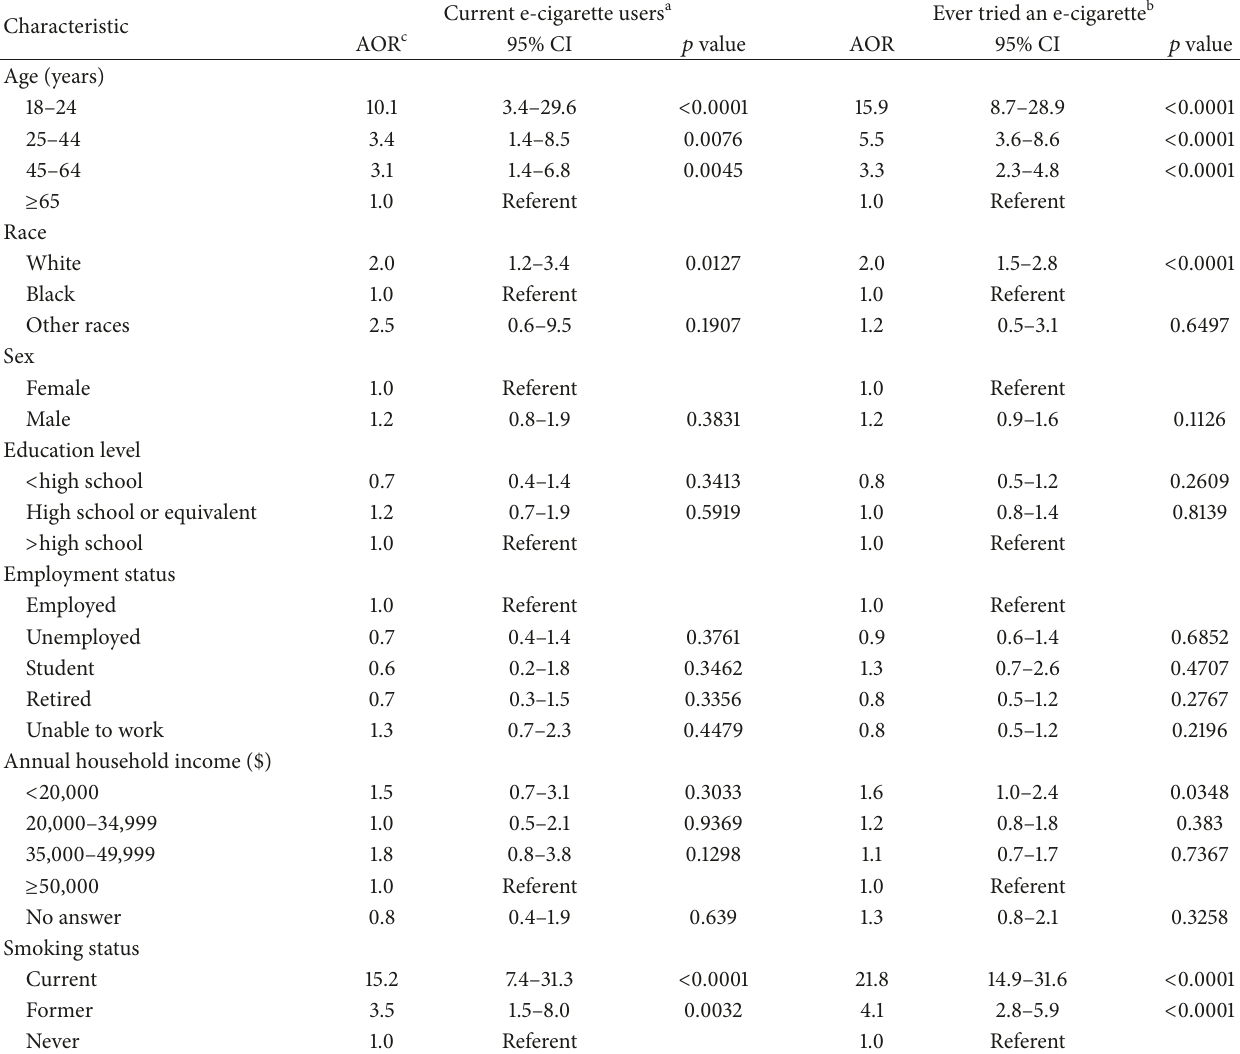
Table 5: Odds of current e-cigarette use and ever tried an e-cigarette among Mississippi adults by sociodemographic characteristics, Behavioral Risk Factor Surveillance System,